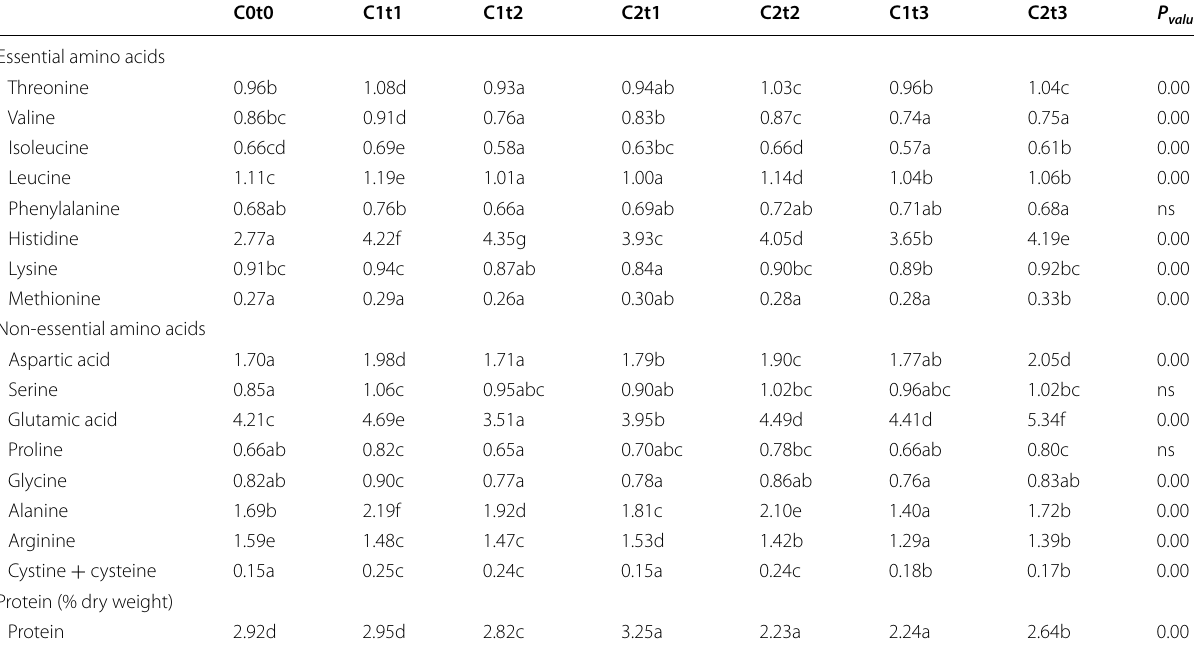
Values are means; means within the same row followed by the same letters are not significantly different at P < 0.05 according to Duncan’s multiple range test, ns: non-significant